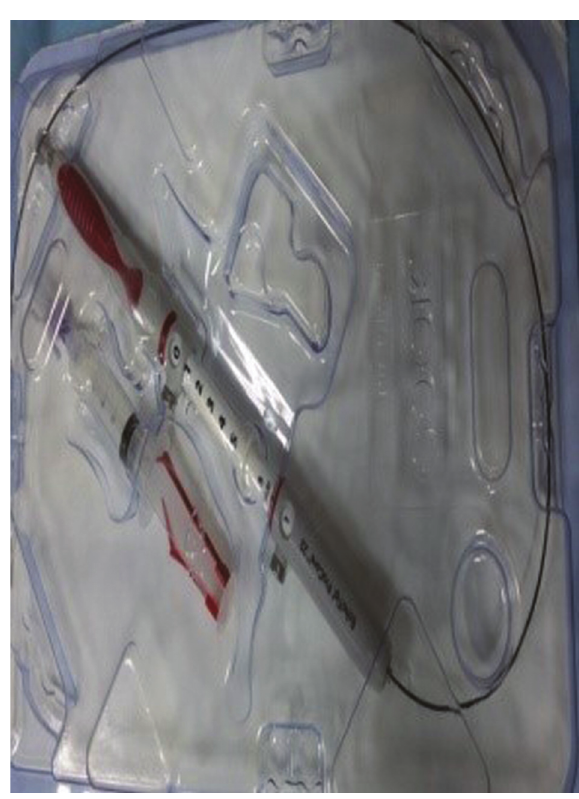
EchoTip ProCore HD ultrasound biopsy needle, 22